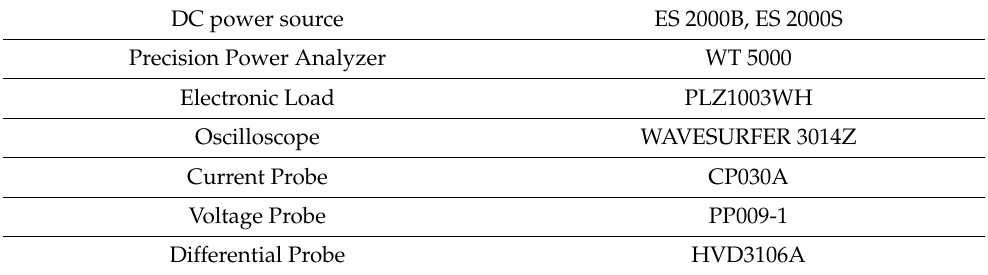
Figure 11. Experimental condition. Table 2. Experimental equipment.